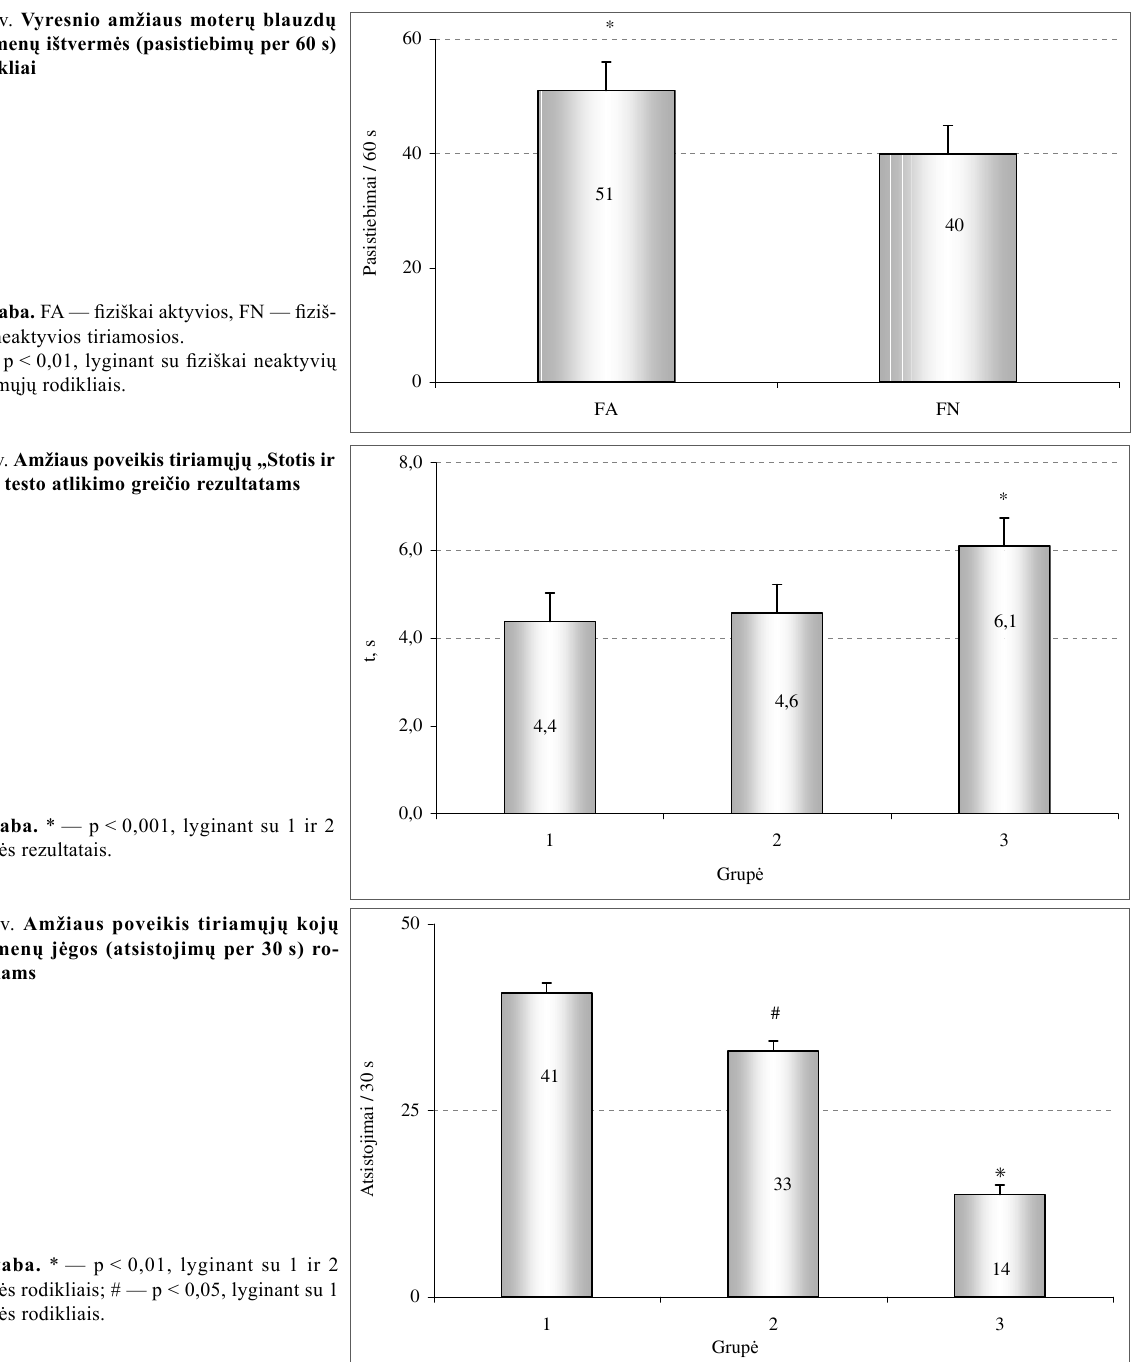
Pastaba. FA — fi ziškai aktyvios, FN — fi ziš- kai neaktyvios